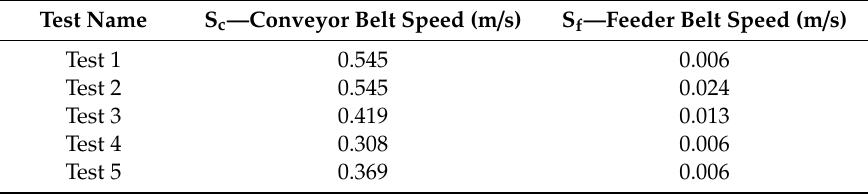
Table 5. The settings of the feeder and the conveyor when testing the sorting e ffi